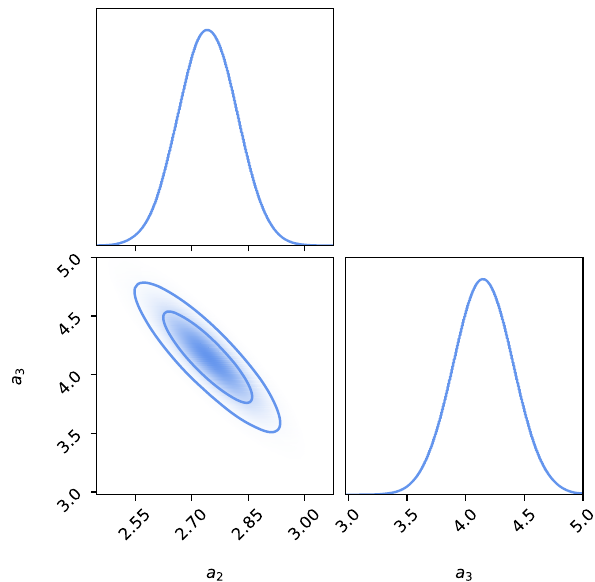
Fig. 4 Marginalized constraints on a 2 and a 3 based on the standard sirens catalog from the third generation GW detector